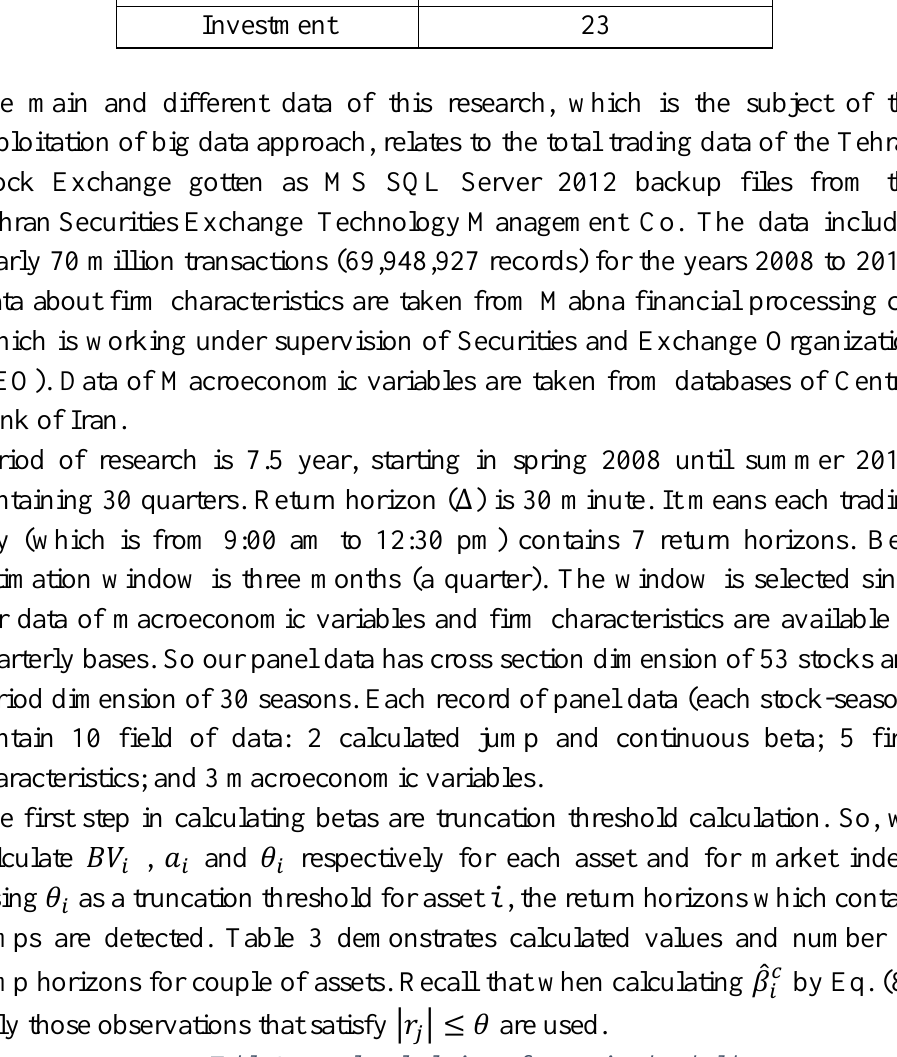
Table 2: sample calculations of truncation